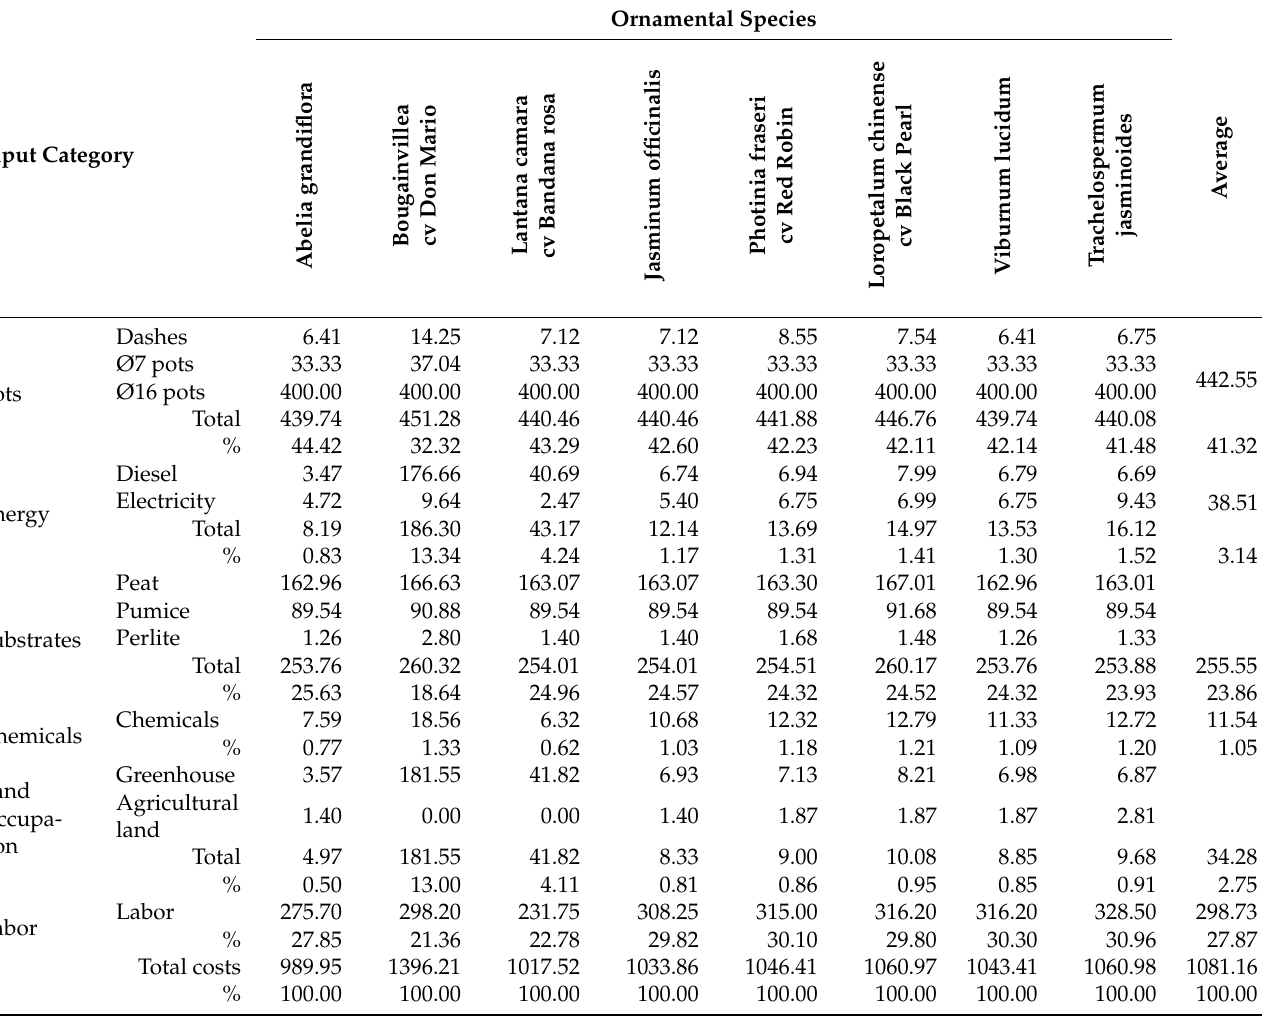
Table A3. Input categories’ costs associated with CM ornamental production model of 1000 plants (based on market prices. Year: